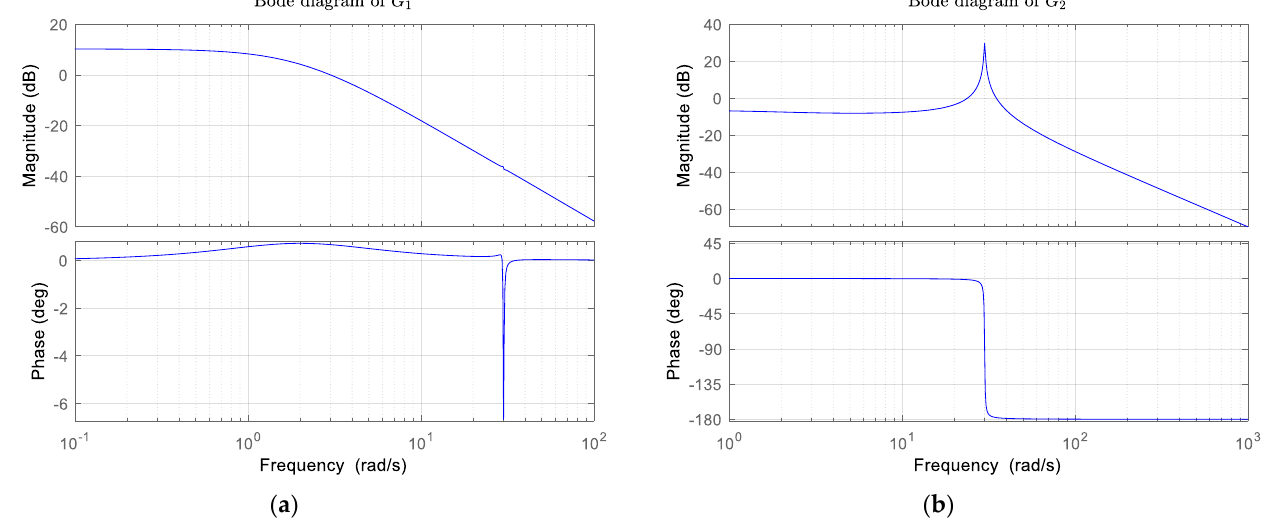
Figure 3. Bode plots of the transfer function. (a) the Bode plot of 𝑮 𝟏 ; (b) the Bode plot of the 𝑮 𝟐 .